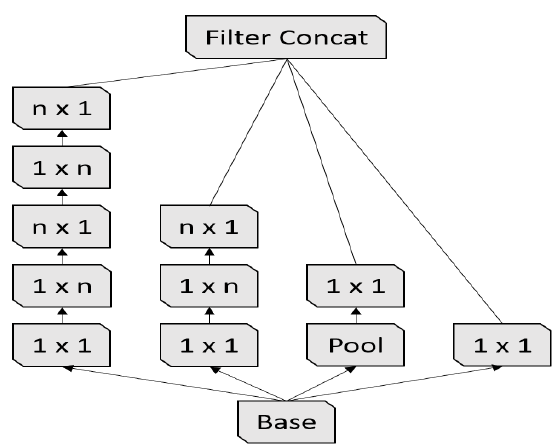
Figure 4. First Inception module [17].